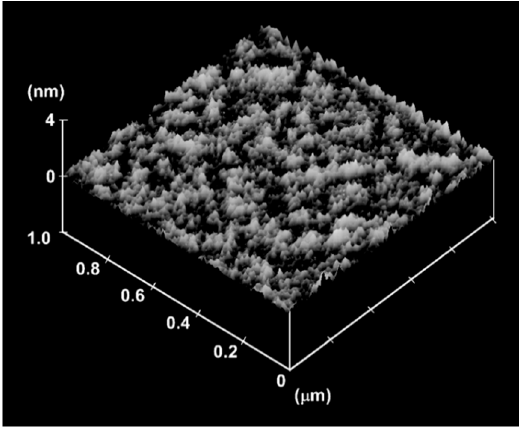
Figure 7. Scanning probe microscope image of the bilayer sample.